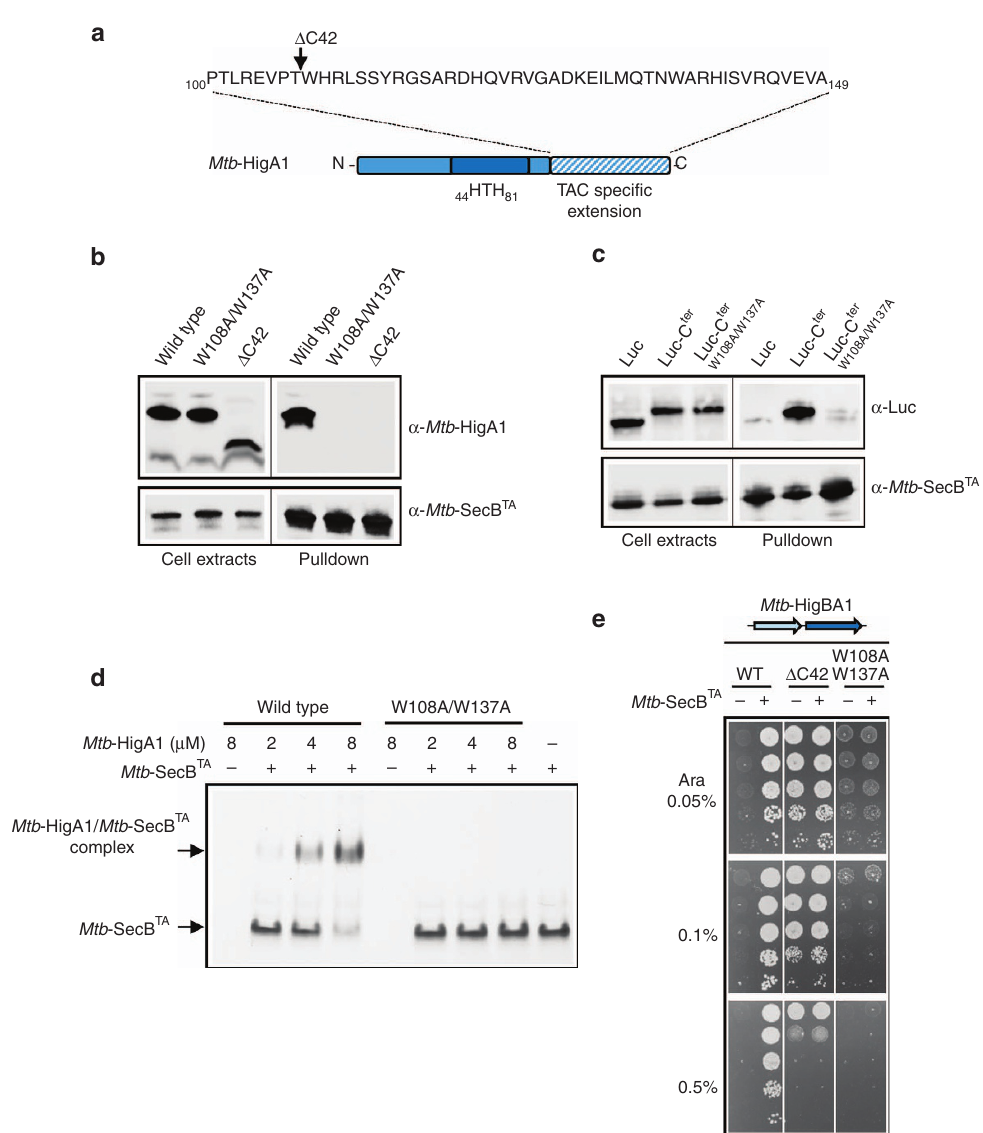
Figure 1 | Mtb -SecB TA interacts with the C-terminal region of Mtb -HigA1. ( a ) Schematic representation of Mtb -HigA1. The dark blue box represents the helix-turn-helix (HTH) motif and the blue hachures the TAC-specific C-terminal extension. The deletion in D C42 is indicated with an arrow. ( b ) In vivo interaction between Mtb -SecB TA and Mtb -HigA1. In vivo pulldowns of His-tagged Mtb -SecB TA and the different Mtb -HigA1 (wild type), Mtb -HigA1 W108A/W137A (W108A/W137A) and Mtb -HigA1 D C42 ( D C42) proteins were revealed using anti- Mtb -HigA1 or anti- Mtb -SecB TA antibodies. ( c ) In vivo interaction between Mtb -SecB TA and the C-terminal extension of Mtb -HigA1 (aa 104–149) wild type (C ter ) or mutant (C ter W108A/W137A ) fused with luciferase (Luc). In vivo pulldowns of His-tagged Mtb -SecB TA and the pK6-Luc constructs were revealed with anti-luciferase or anti- Mtb -SecB TA antibodies. Full blots for b and c are shown in Supplementary Fig. 6. ( d ) In vitro native PAGE separation of complexes between Mtb -HigA1 or Mtb -HigA1 W108A/W137A , at 2, 4 and 8 m M and Mtb -SecB TA (16 m M). Full gel for d is shown in Supplementary Fig. 7. ( e ) Suppression of Mtb -HigB1 toxicity by Mtb -HigA1 and Mtb -SecB TA in E. coli . Strains W3110 D secB containing the plasmid pSE ( (cid:2) ) or pSE- Mtb -SecB TA ( þ ; with Mtb -SecB TA under control of Ptrc promoter) were transformed with pK6-based plasmids harbouring Mtb -HigA1, Mtb -HigA1 D C42 or Mtb -HigA1 W108A/W137A under control of P